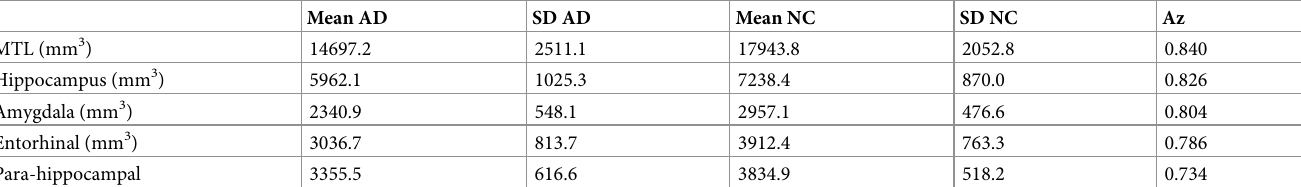
Table 2. Mean volumes, standard deviations and detectability index Az of various anatomical